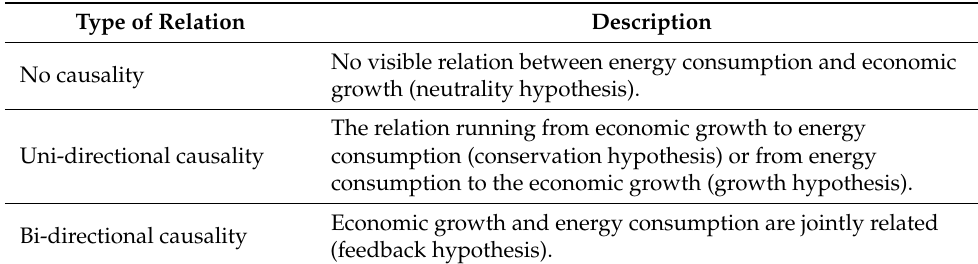
Table 1. Causality between energy consumption and GDP. Source: [22–24]. Type of Relation Description No visible relation between energy consumption and economic No causality growth (neutrality hypothesis). The relation running from economic growth to energy Uni-directional causality consumption (conservation hypothesis) or from energy Economic growth and energy consumption are jointly Bi-directional causality